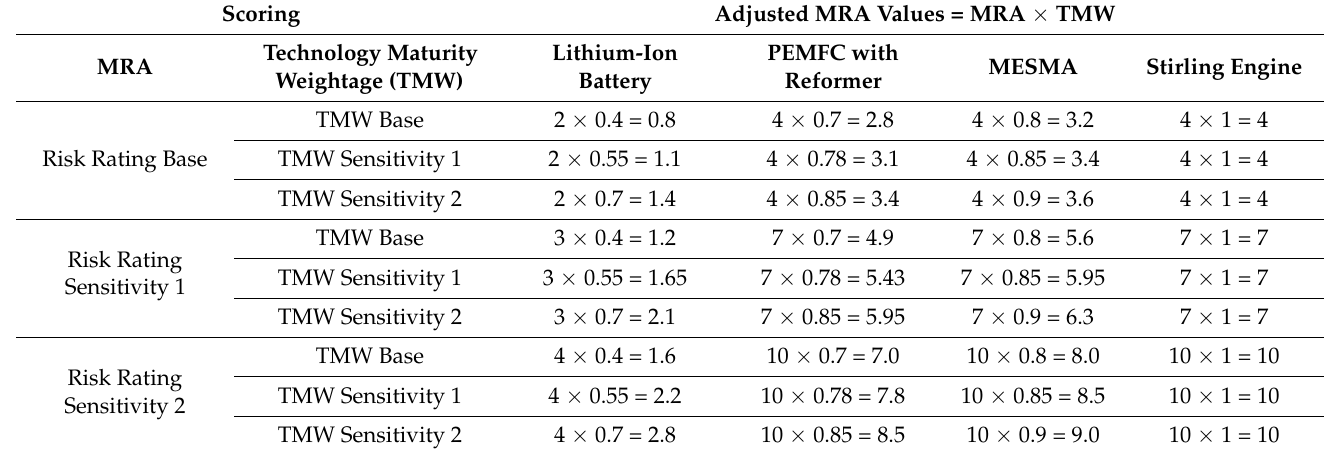
Table 11. Sensitivity Analysis of